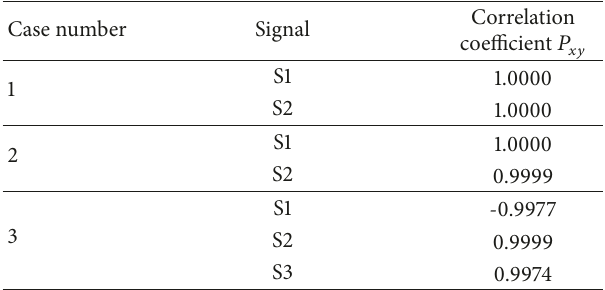
Table 2: The correlation coefficient between the source signals and the separated